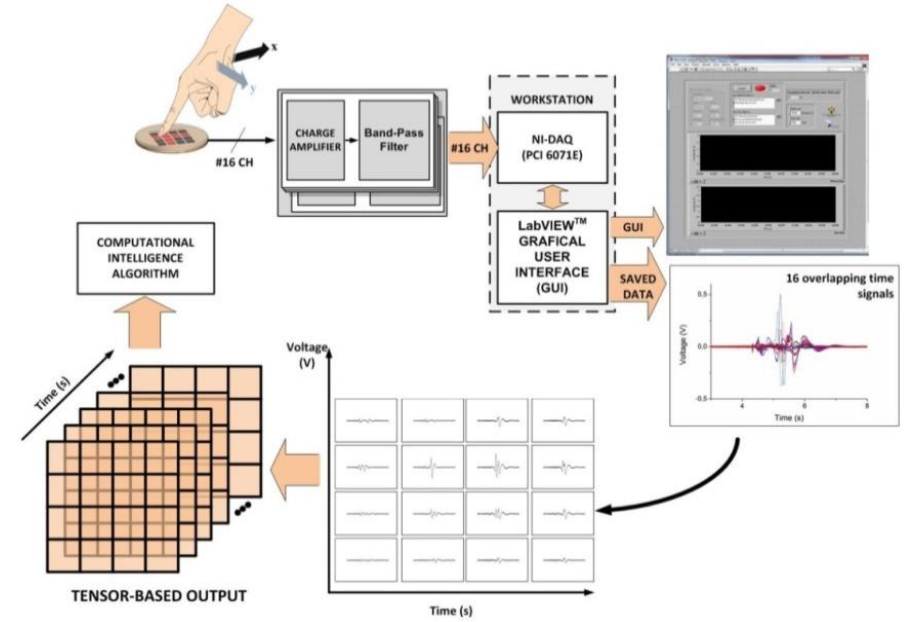
Figure 3. Scheme of the tactile acquisition system. Focus is on the tensor representation of output